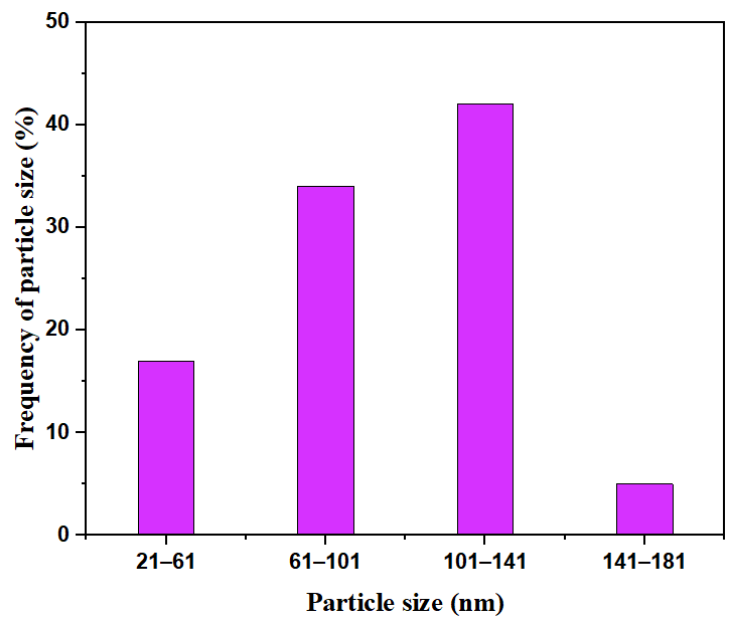
3 O 4 catalyst particles.